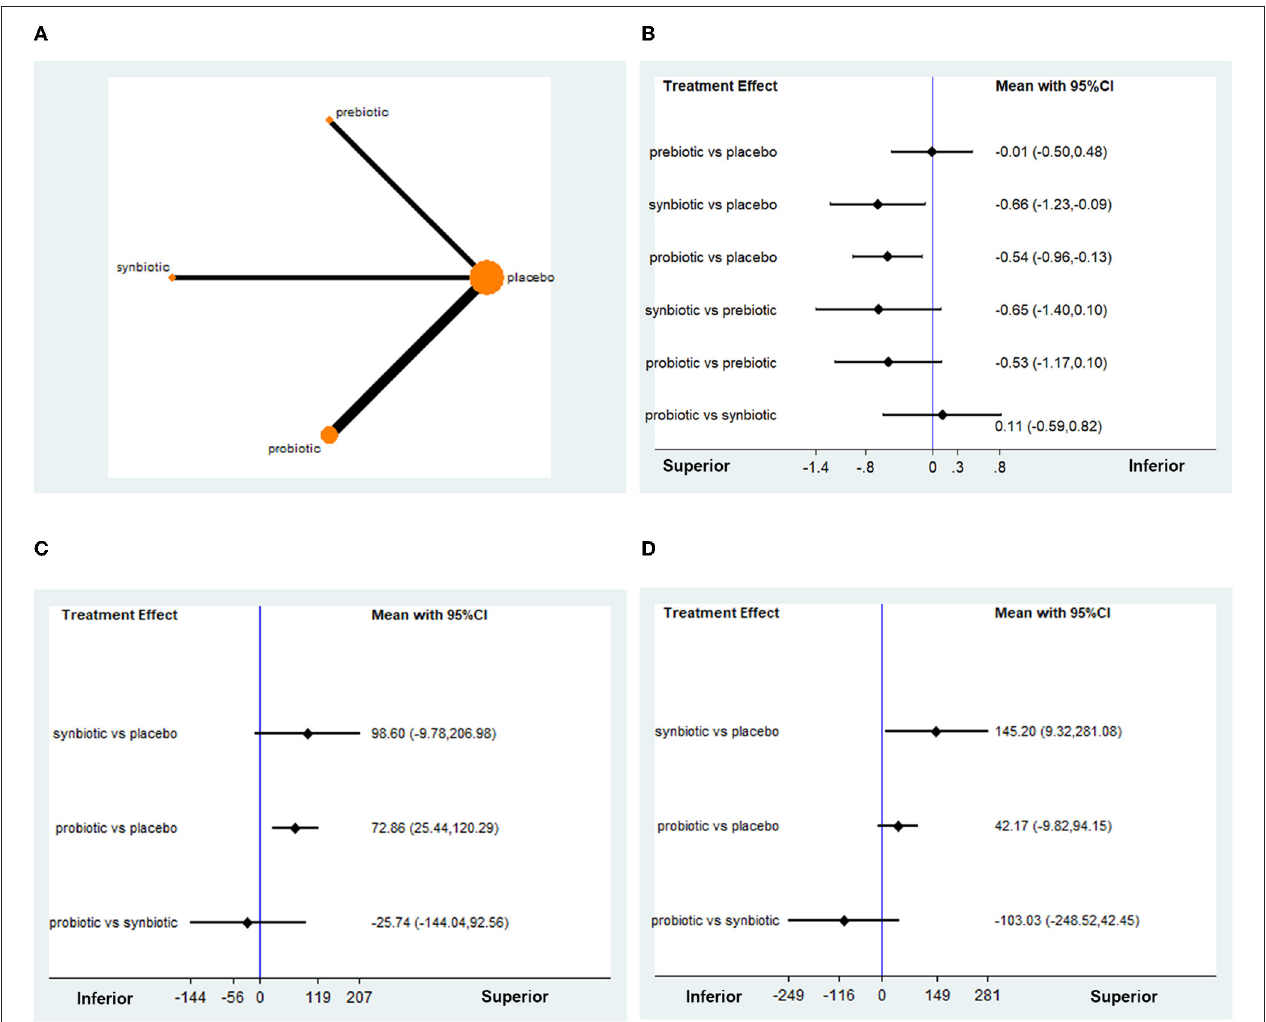
FIGURE 4 | Network meta-analysis results for the effects of probiotic, prebiotic, and synbiotic supplementation on oxidative stress indicators. (A) The network structures. (B) MDA. (C) GSH. (D) TAC. MDA, malondialdehyde; GSH, glutathione; TAC, total antioxidant